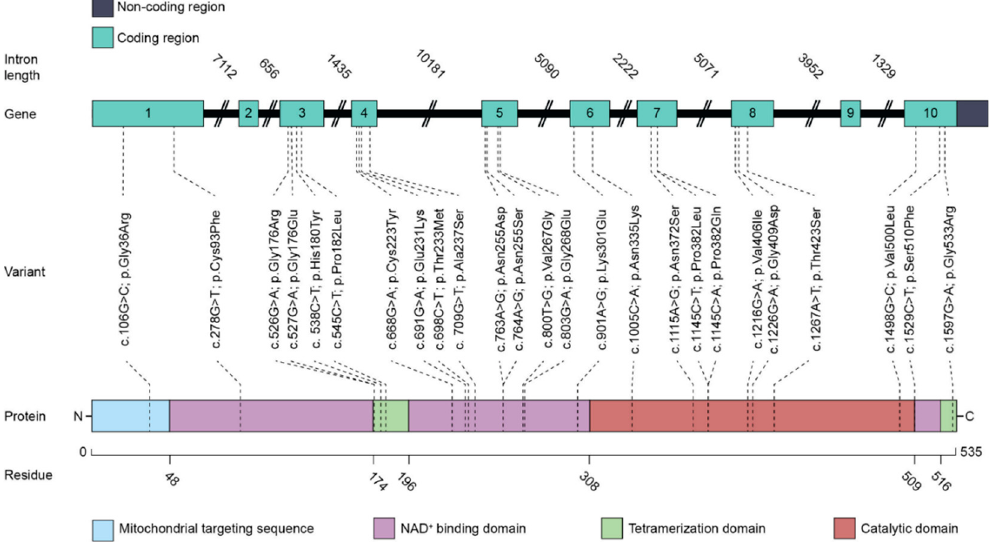
Figure 3. Exon and domain structure of SSADH, and localization of selected SSADH-D missense variants. The human SSADH isoform 2 exhibits 535 amino acids. Green boxes show the exons, joined by the black lines representing introns, the length of which is given above the lines. Colored blocks refer to the protein domains as indicated. Numbers below the bar refer to the first amino acid of the respective domain. Dashed lines connect the selected disease-causing variants with the respective exons and protein domains.